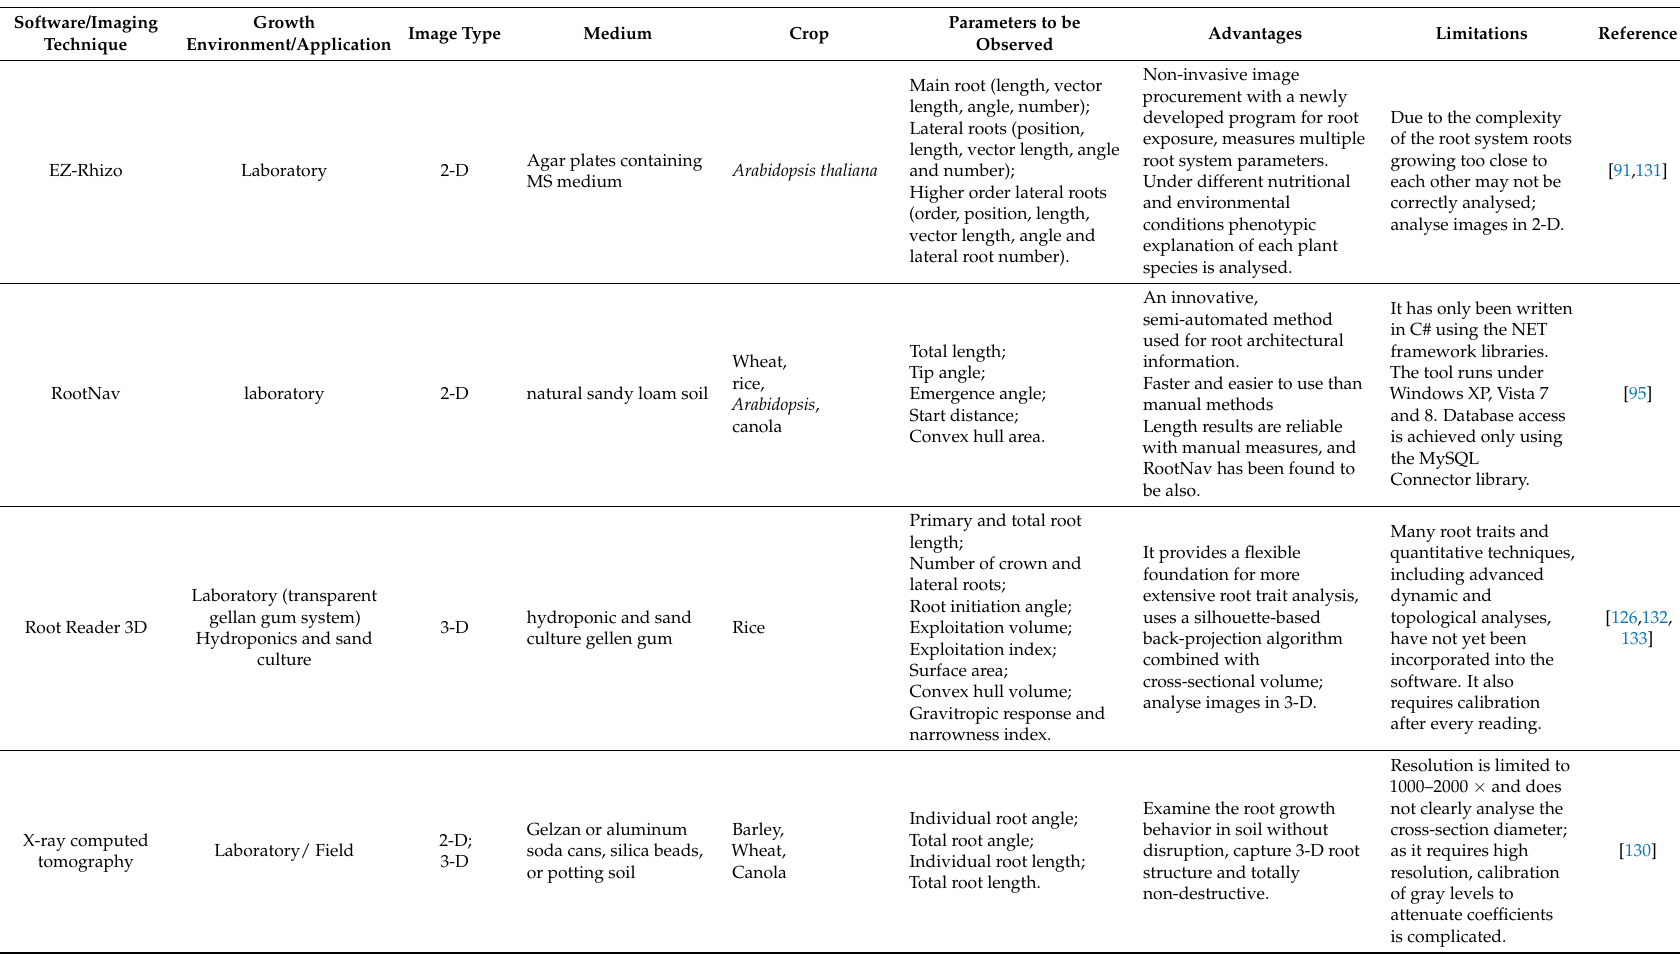
Table 3. Techniques/softwares used for image analysis for root phenotyping under controlled/field